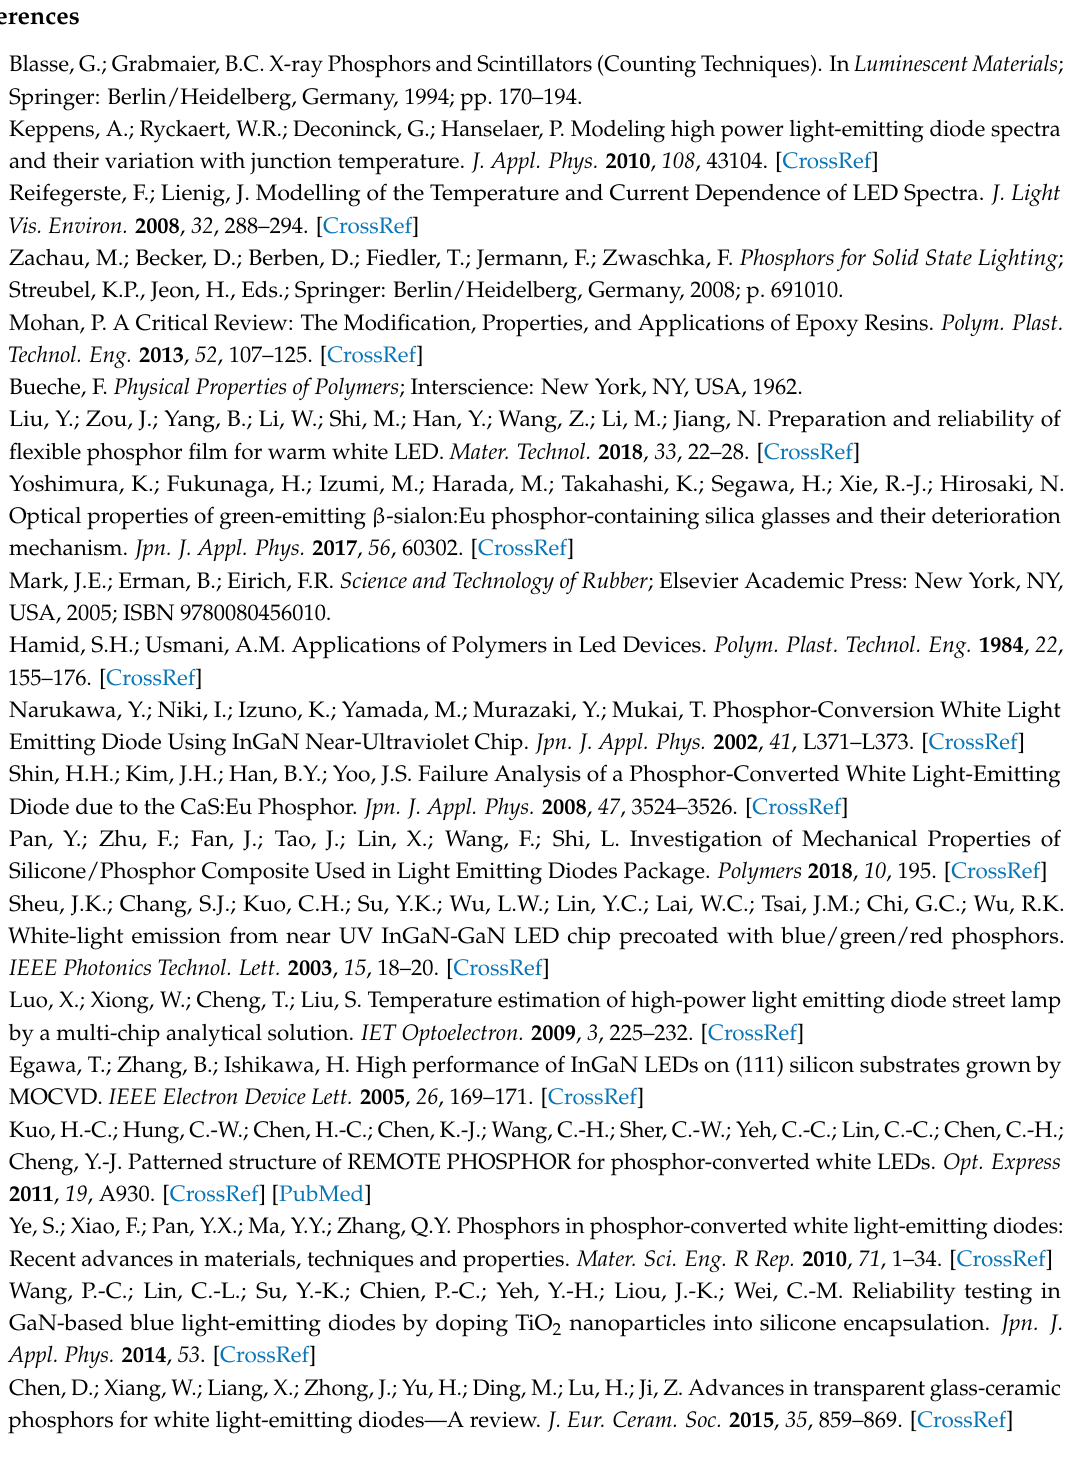
vs. temperature per heating rate for calculating the activation energy of Resin 2, Figure S4: Comparison of heat flow vs. temperature per heating rate for calculating the activation energy of Resin 3, Figure S5: Resulting force vs. compression displacement for Resin 1, 2, and 3, Table S1: Absorption peak of each resin and functional group in absorbance